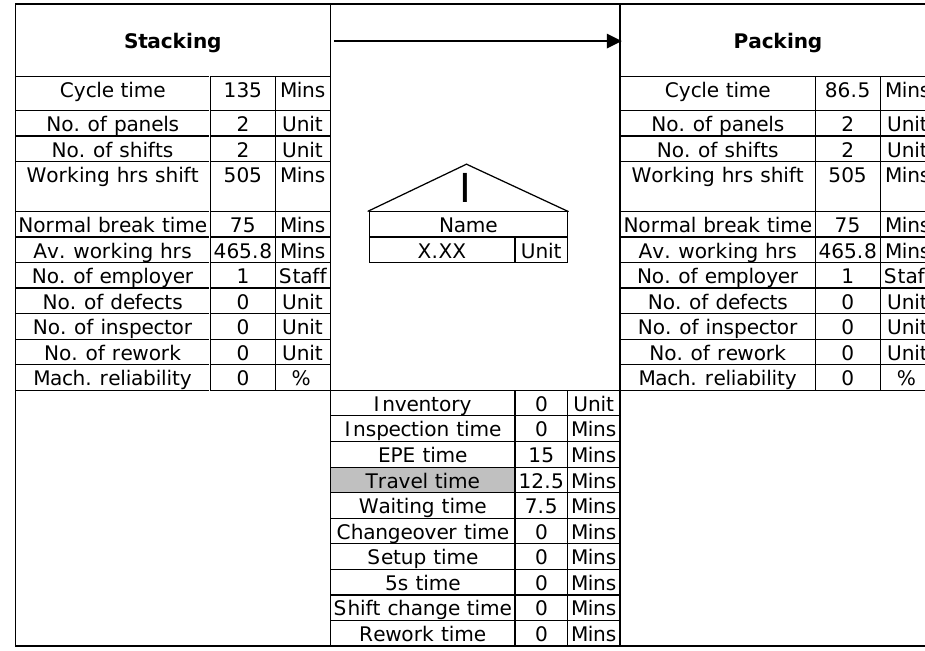
Figure 4. “Travel time wastages (stacking to